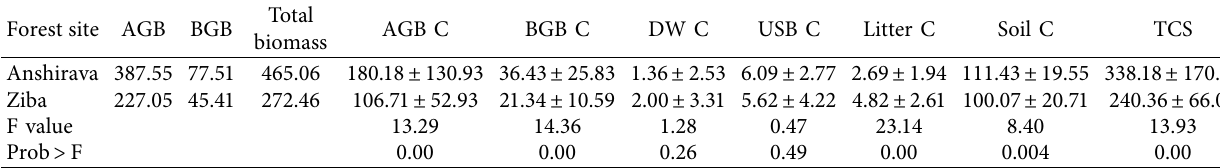
Table 4: ANOVA of mean carbon stock in different pools (t ha − 1 ).